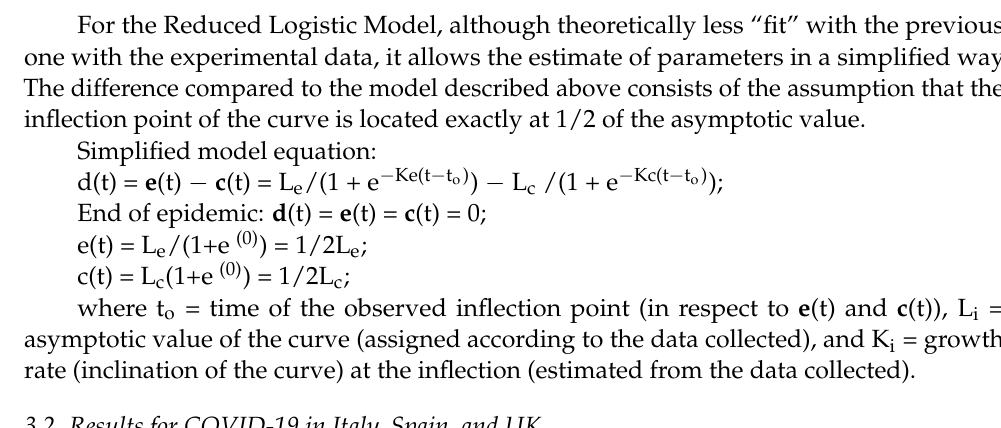
Figure 2. COVID-19 epidemic time-course in Spain.